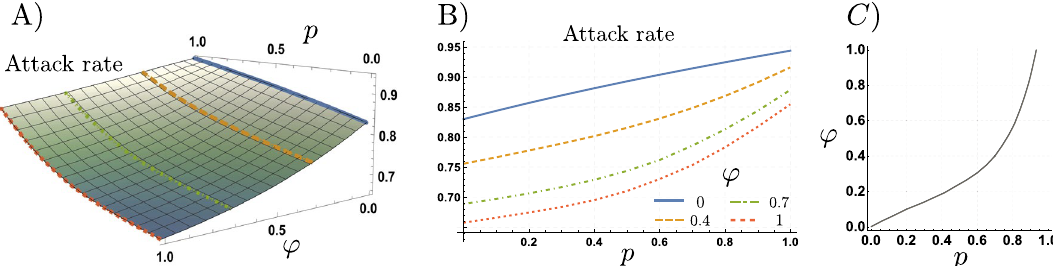
the scenario of no surveillance and no risk-takers are those in Table